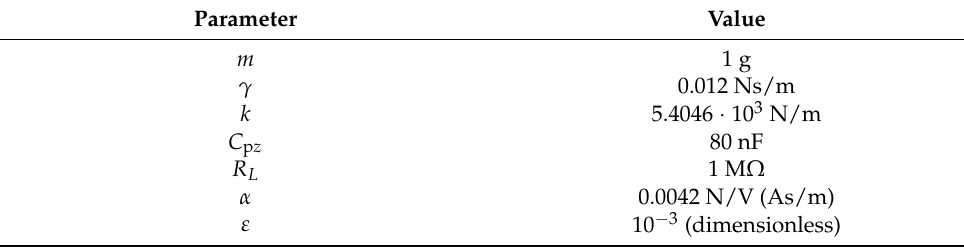
Table 1. Values of the energy harvester